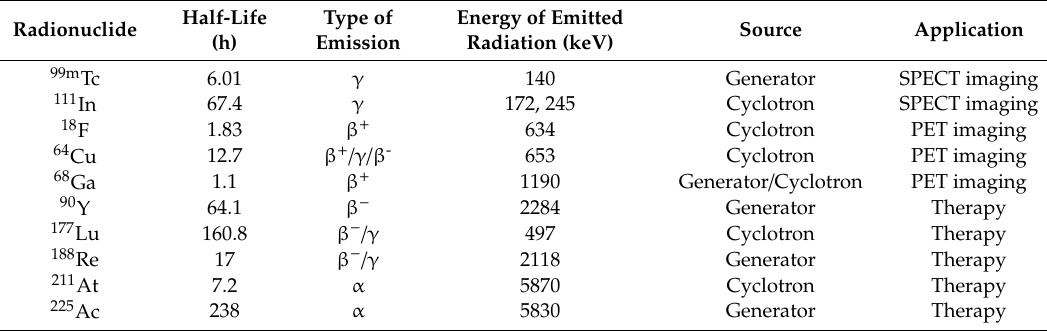
Figure 4. Schematic design of a radiometallated bioconjugate. Table 2. Some of the main radionuclides studied for imaging and therapy (SPECT—Single-Photon Emission Computed Tomography; PET—Positron Emission